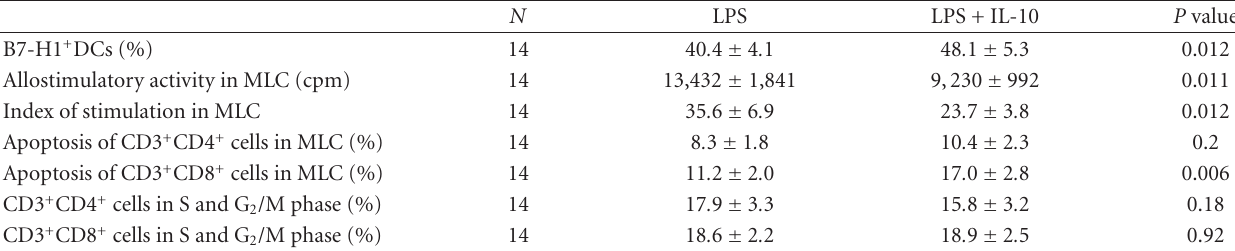
Table 2: The e ff ects of exogenous IL-10 on phenotypic and functional properties of healthy donor